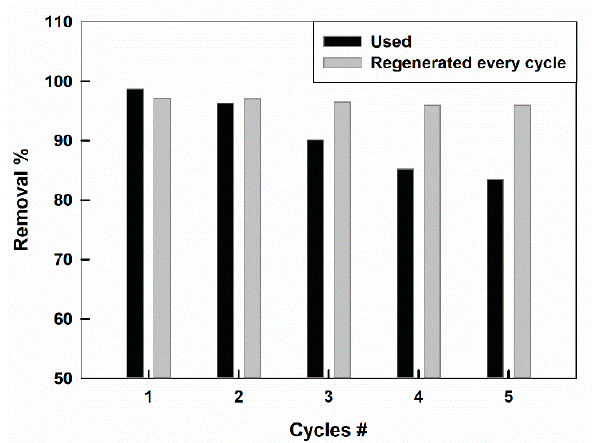
Figure 8. The removal % of (black) used and (gray) regenerated CTAB-capped La 0.9 Sr 0.1 FeO 3 as a function of the number of use cycles.